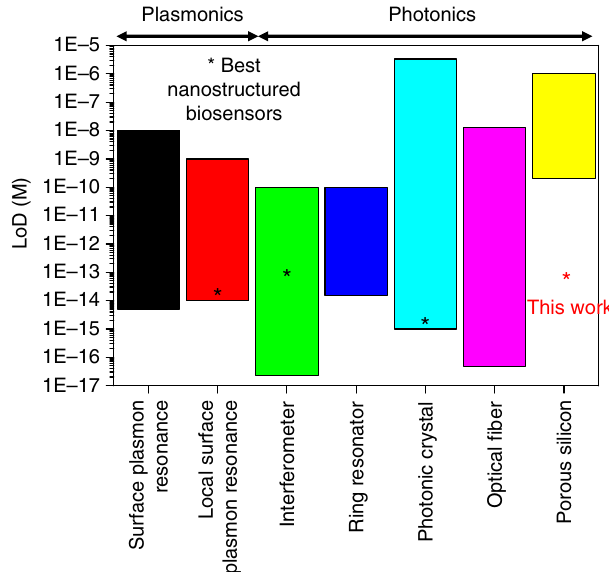
Fig. 1 State-of-art plasmonic and photonic platforms for high-sensitivity label-free biosensing. For each platform, namely SPR 54 , LSPR 55 , interferometer 56,57 , ring resonator 58 , photonic crystal 59 , optical fi ber 60 ,